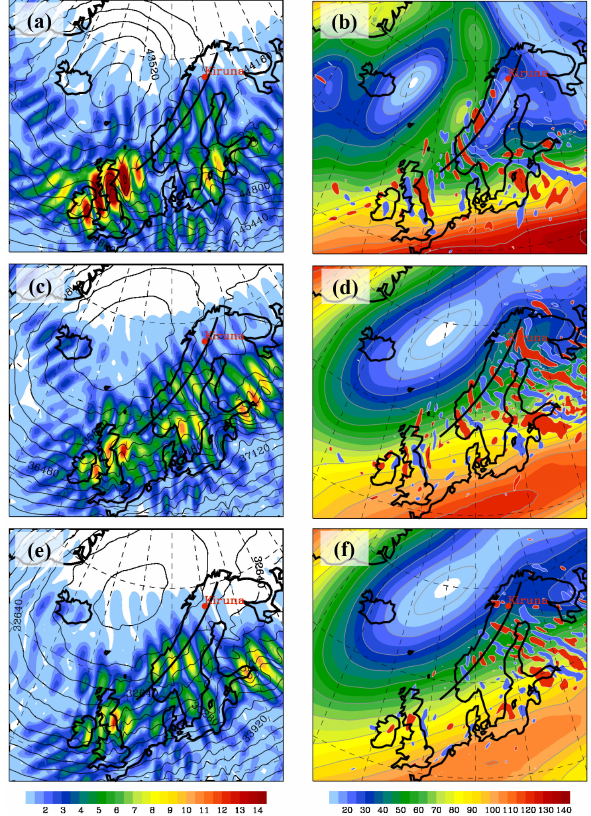
Figure 4. (a, c, d) Composite of the magnitude of V IGW color shaded) from the normal-mode analysis and the geopoten- tial height (m, black contour lines) from IFS operational analyses. (b, d, f) Composite of the magnitude of the balanced wind V BAL (ms − 1 , color shaded) from the normal-mode analysis and the hori- zontal divergence (values larger or smaller than ± 2 × 10 − 4 s − 1 are filled with red and blue, respectively) from operational analyses. The plots are at 1hPa ( ∼ 48km; a , b ), 3hPa ( ∼ 40km; c , d ), and 5hPa ( ∼ 36km; e , f ) and they are valid at 06:00UTC on 30 Jan- uary 2016. The black line marks the baseline of the vertical sections shown in Fig. 6.